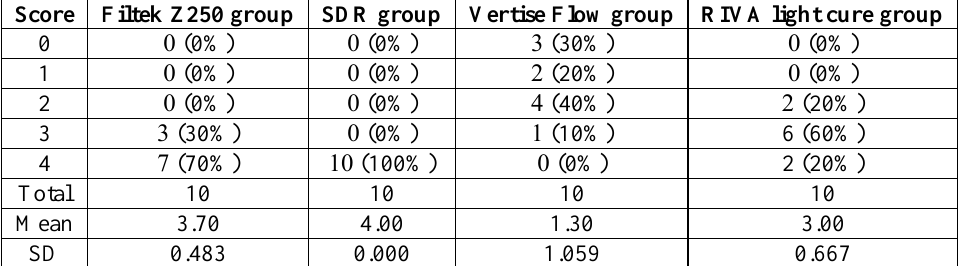
Table 1: The scores percentages for experimental groups